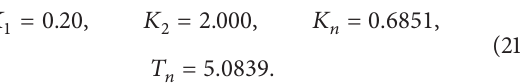
Figure 12: Normalized responses of 𝐶/𝑅 and 𝐷/𝑅 of Example 2.